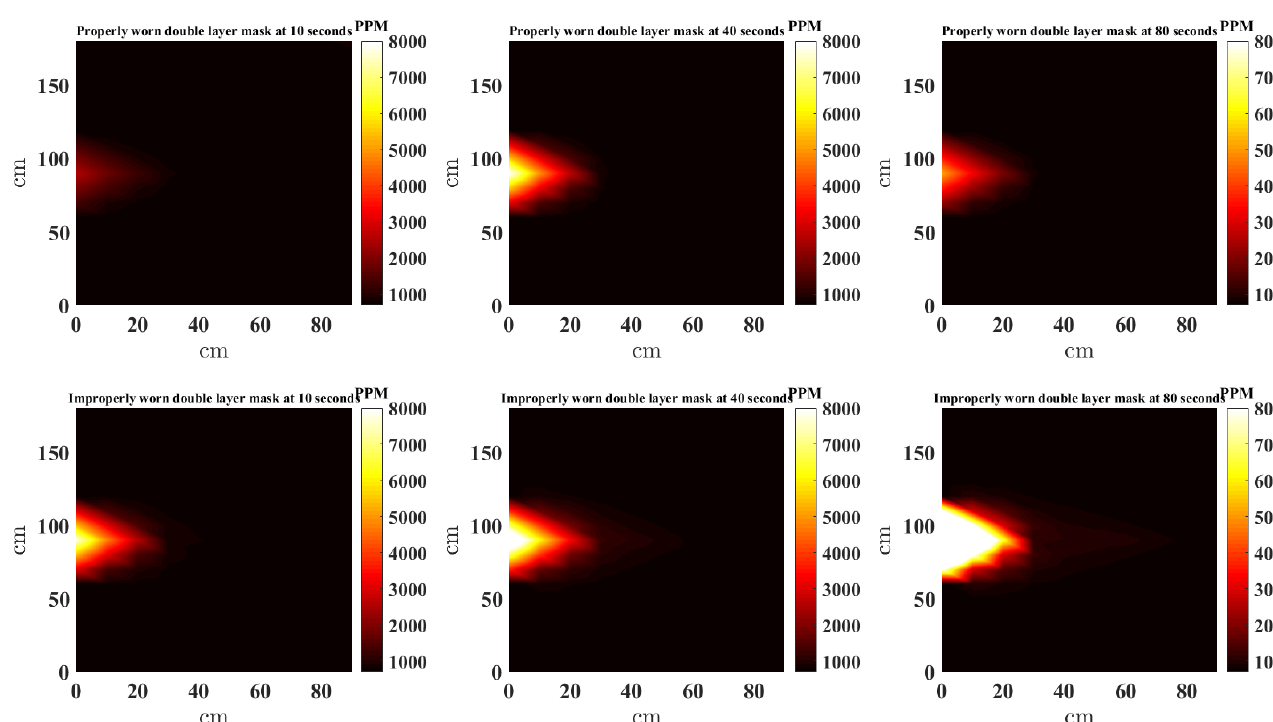
Figure 8. Interpolated CO 2 with properly and improperly worn single layer mask.